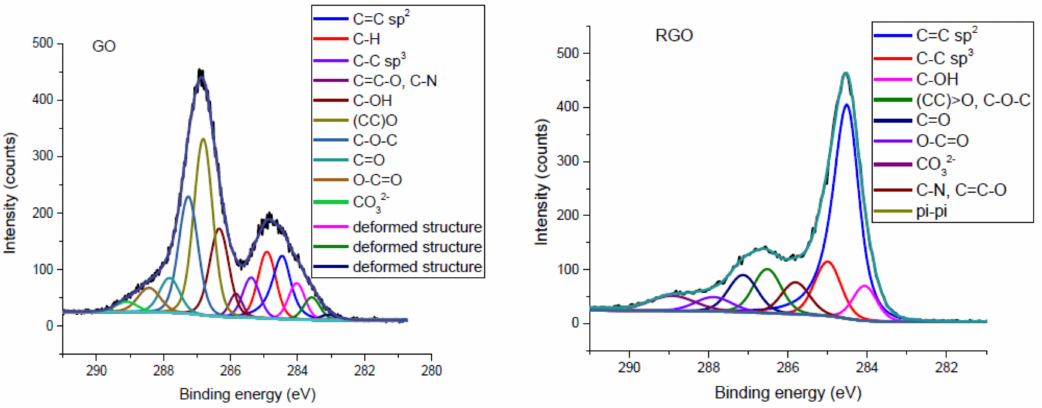
Figure 3. XPS C1s spectra of GO and RGO and their